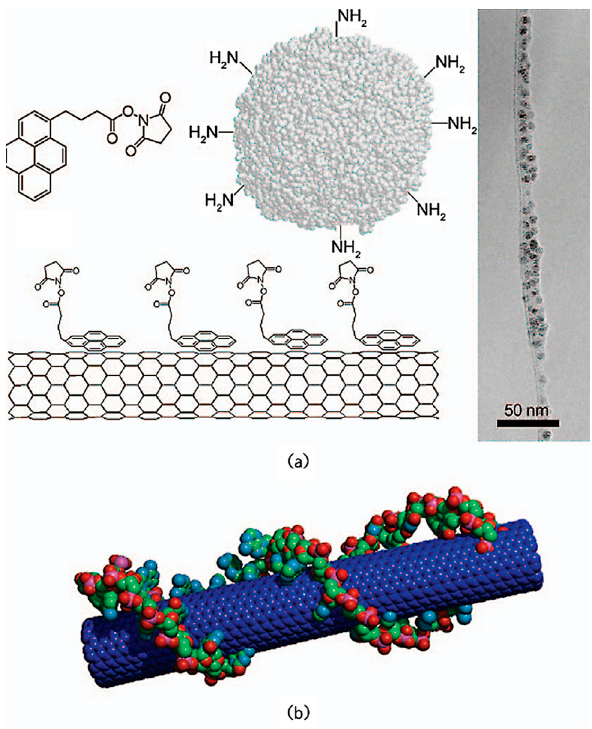
Figure 2. Non-covalent functionalization of carbon nanotubes (CNTs): ( a ) With a surfactant and ( b ) with a polymeric agent [32]. (Adapted with permission from [32], Elsevier, 2016.)